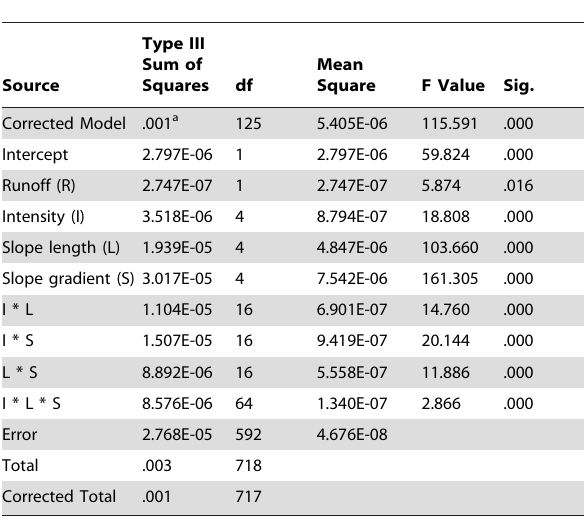
Table 4. Univariate Analysis of Variance for selected parameters with interrill erosion rate as a dependent variable using all effective steady-state